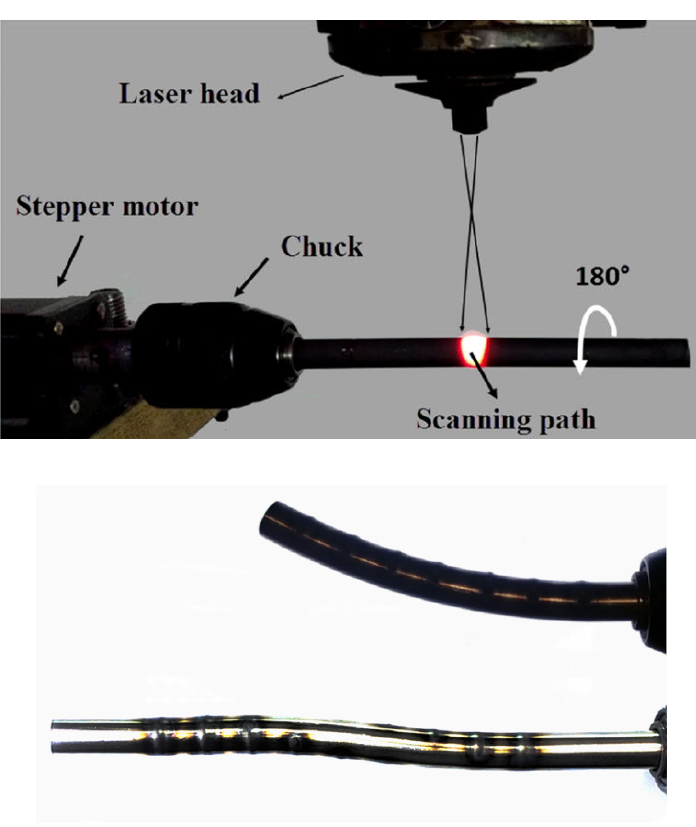
Figure 3. 2D and 3D tube bending [55]. (Adapted from [55], with permission from Elsevier, 2020).